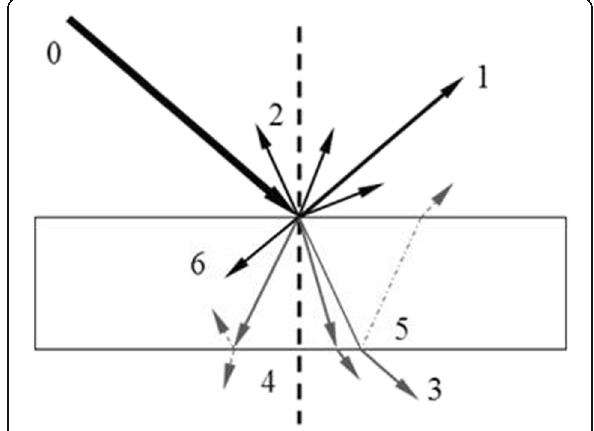
Fig. 1 Reflections and refractions on the